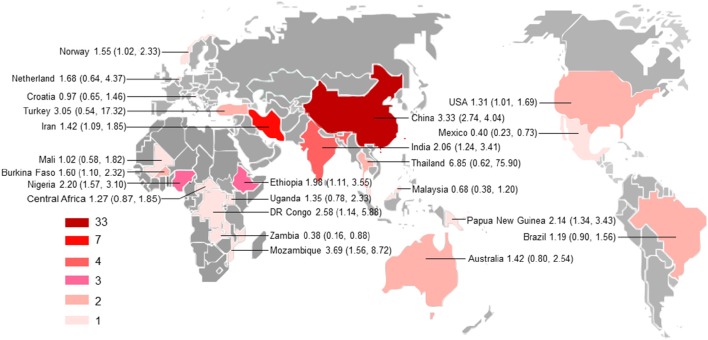
Geographical distribution of the included studies. The map was created using MapInfo Professional software version 9.5. Pooled odds ratio and 95% confidence interval are shown for each country.